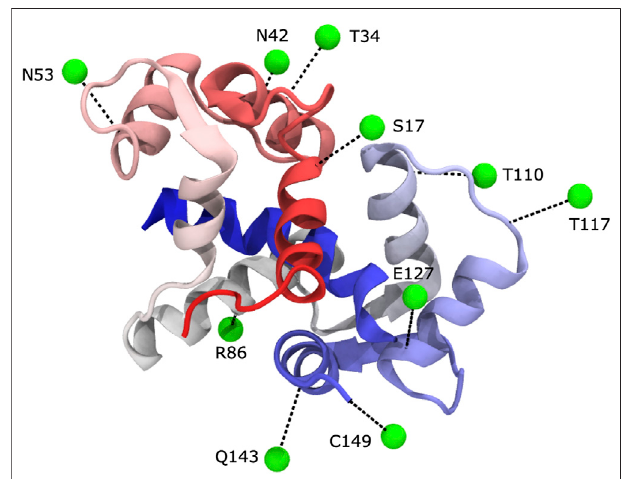
FIGURE 1 | We carried out PRE experiments with ten different label sites. In each experiment, Calmodulin was MTSL-labeled at a different position. Spin labels were generally located in predicted surface-exposed sites within secondary structures. Spin labels are shown in green as virtualsites(seetext),and theircorresponding cysteinemutationlinkagesiteis shown in black (PDB